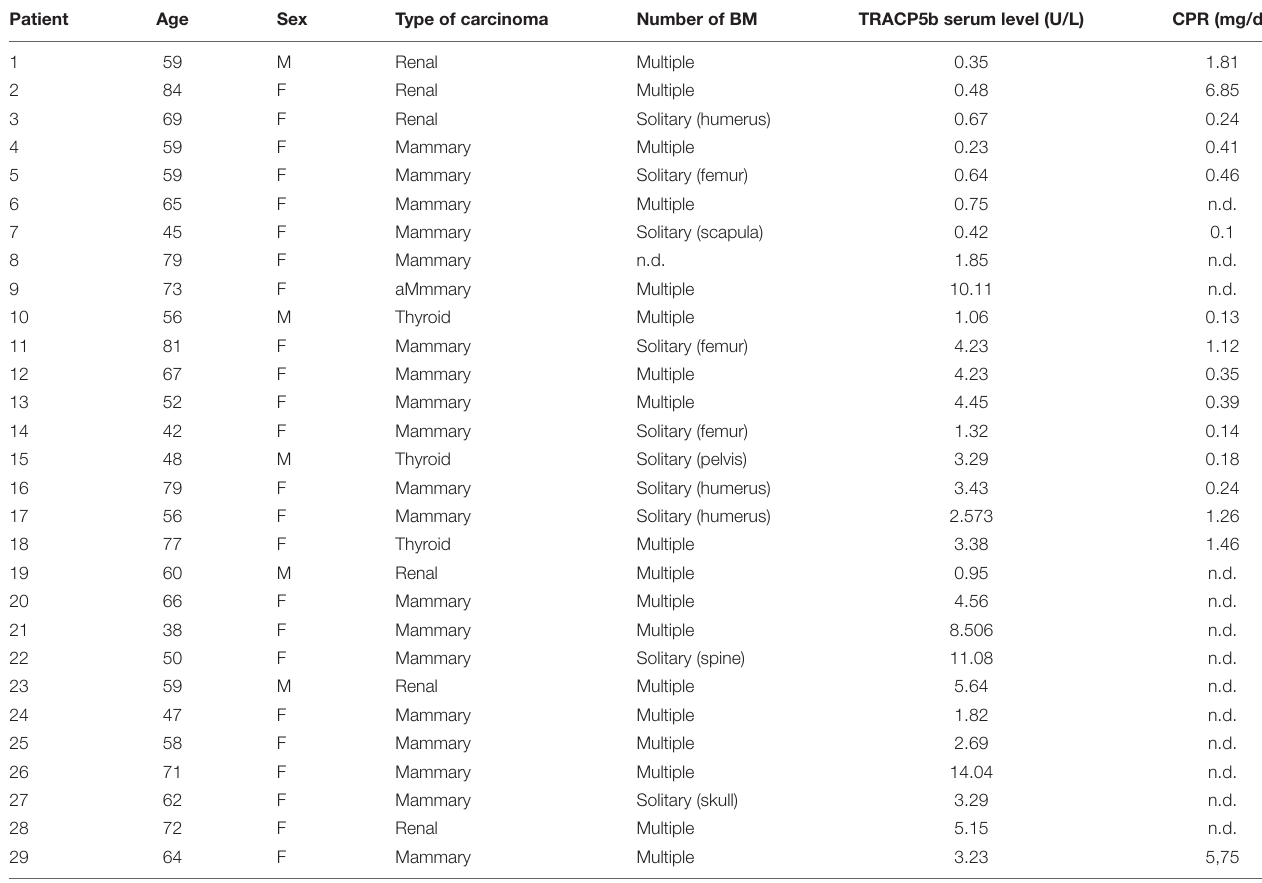
TABLE 3 | Clinical features of patients with